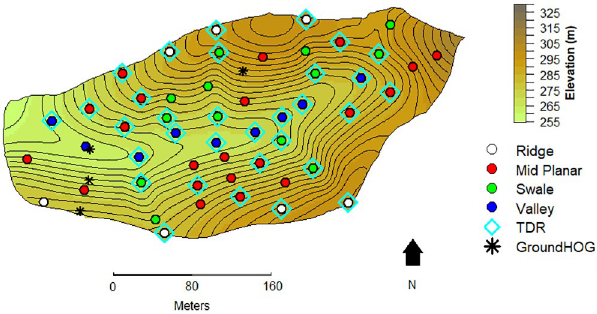
Fig 1. Susquehanna Shale Hills Critical Zone Observatory macroplot site map. Elevation map of Susquehanna Shale Hills Critical Zone Observatory with included topographical contoured lines. White, red, green, and blue dots represent macroplot sites that were established at ridge top, mid-slope planar, swale, and valley floor locations, respectively. Cyan diamonds represent macroplot volumetric time domain reflectometry (TDR) sensors locations, 2–3 per plot. TDR observations were also taken at sites with previously installed soil moisture sensors termed “GroundHOG” sites, which were represented on the map as asterisks. GroundHOG stands for ground hydrologic observation gear. GroundHOG sites have additional gas, water and measuring sensors used by the SSHCZO that were not used in this